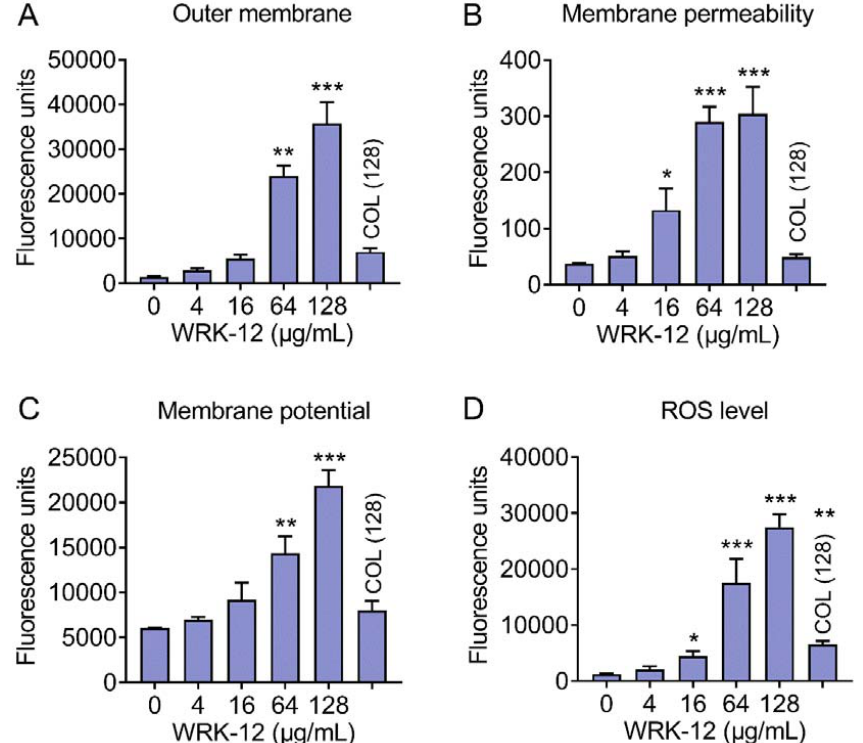
Figure 6. Bactericidal mechanisms of WRK ‐ 12 against multidrug resistant E. coli. (A and B) WRK ‐ 12 increases outer membrane and cytoplasmic membrane permeability in a dose ‐ dependent manner. Permeability of outer membrane ( A ) and the whole membrane permeability ( B ) were assessed with fluorescence probes 1 ‐ N ‐ phenylnaphthylamine (NPN, excitation 350 nm and emission 420 nm) and propidium iodide (PI, excitation 535 nm and emission 615 nm), respectively, after exposure to WRK ‐ 12 or colistin (128 μ g/mL) for 1 h. ( C ) WRK ‐ 12 dissipates membrane potential in E. coli , probed by monitoring fluorescence intensity of 3,3 ′‐ dipropylthiadicarbocyanine iodide (DiSC3(5), excitation 622 nm and emission 670 nm). ( D ) WRK ‐ 12 triggers the production of ROS, determined by 2 ′ ,7 ′‐ dichlorodihydrofluorescein diacetate (DCFH ‐ DA, excitation 488 nm and emission 525 nm). All data were presented as mean ± SD, and significance was determined by non ‐ parametric one ‐ way ANOVA. * p < 0.05, ** p < 0.01, *** p < 0.001. Colistin (128 μ g/mL) was used as a control.